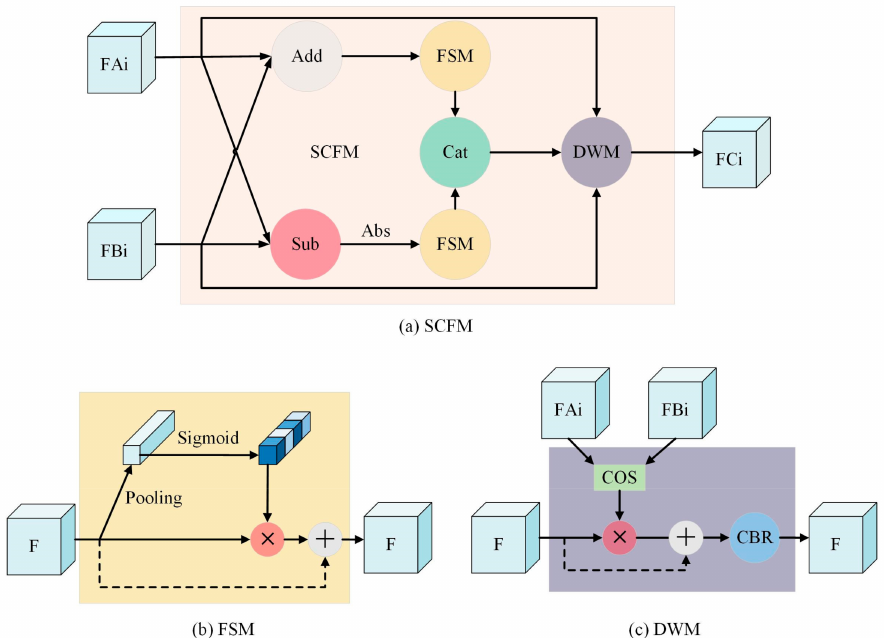
Figure 2. ( a ) Symmetric Change Feature Fusion Module; ( b ) Feature Selection Module; ( c ) Dissimilar- ity Weighting